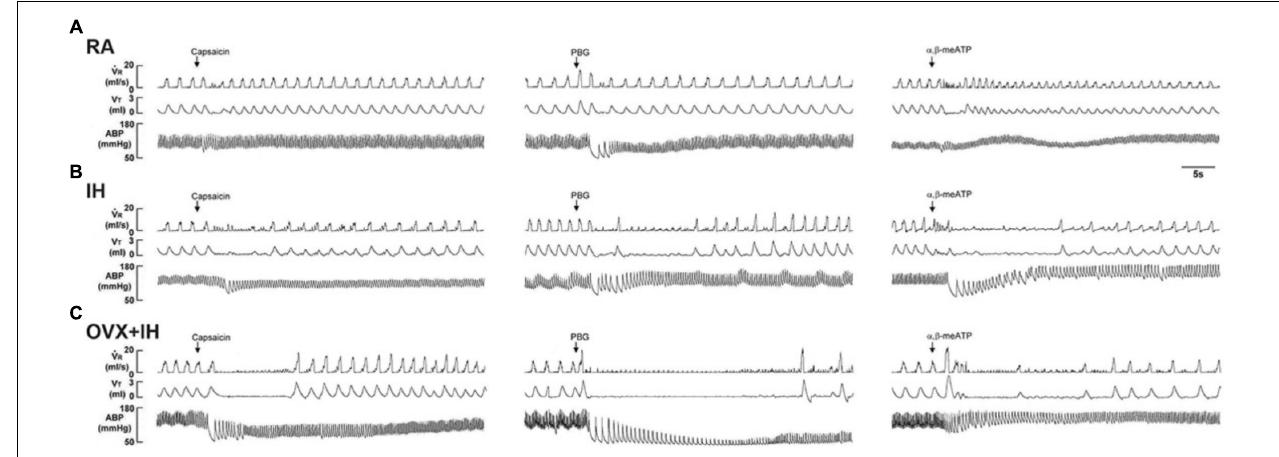
FIGURE 1 | Ventilatory responses to the intravenous injection of three types of stimulants in three female rats after 14 days of exposure to room air (RA) or intermittent hypoxia (IH). (A) Responses of an intact rat exposed to RA; (B) responses of an intact rat exposed to IH; (C) responses of an ovariectomized (OVX) rat exposed to IH (OVX + IH). Sixteen hours after the last exposure, the animals’ responses to capsaicin (1.0 µ g/kg), phenylbiguanide (PBG; 8.0 µ g/kg), and α , β -methylene-ATP ( α , β -meATP; 10 µ g/kg) were measured in each rat. These chemicals are stimulants of lung vagal C fibers and were injected into the jugular vein as a bolus (0.1 ml volume) as indicated by the arrows. The tip of the injection catheter was inserted close to the right atrium. Approximately 15 min elapsed between any two injections. ˙ VR, respiratory flow; VT, tidal volume; ABP, arterial blood pressure.